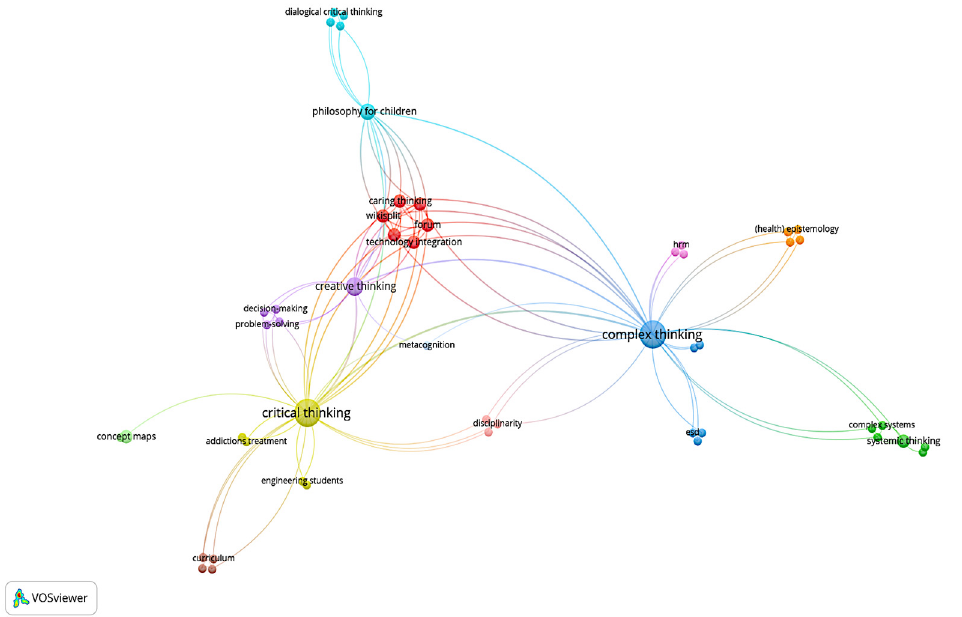
Figure 3. Keywords of the studies and connection